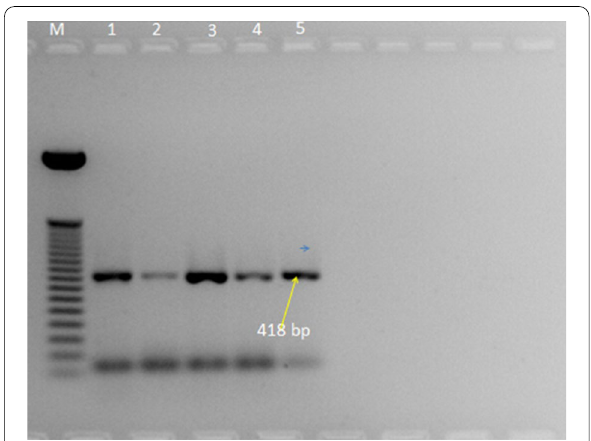
Fig. 1 PCR analysis of the DNA from Golovinomyces cichoracearum isolates collected from different geographical locations with